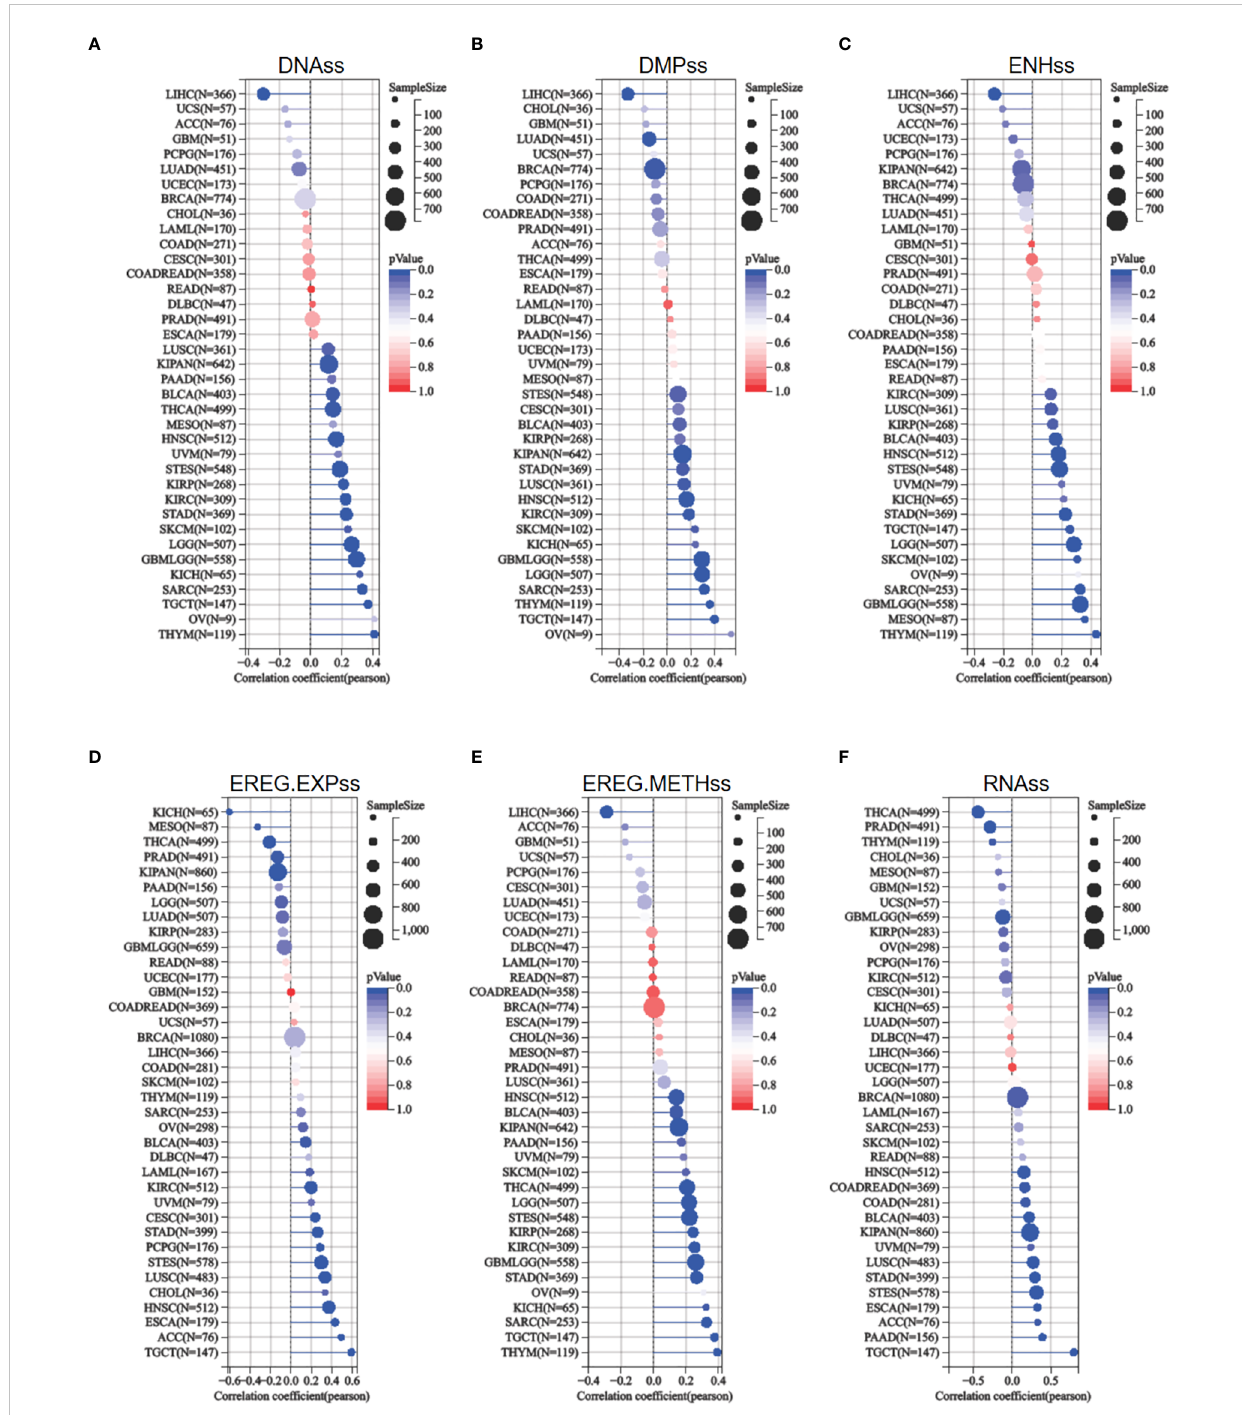
FIGURE 7 Relationship between ETV4 and cancer stemness in various cancer types. (A) DNA expression-based stemness score (DNAss), (B) Differentially methylated probes-based stemness score(DMPss), (C) Enhancer elements/DNA methylation-based stemness score (ENHss), (D) Epigenetically regulated RNA expression-based stemness score (EREG.EXPss), (E) Epigenetically regulated DNA methylation-based stemness score(EREG.METHss), and (F) RNA expression-based stemness score(RNAss) were calculated using the TCGA